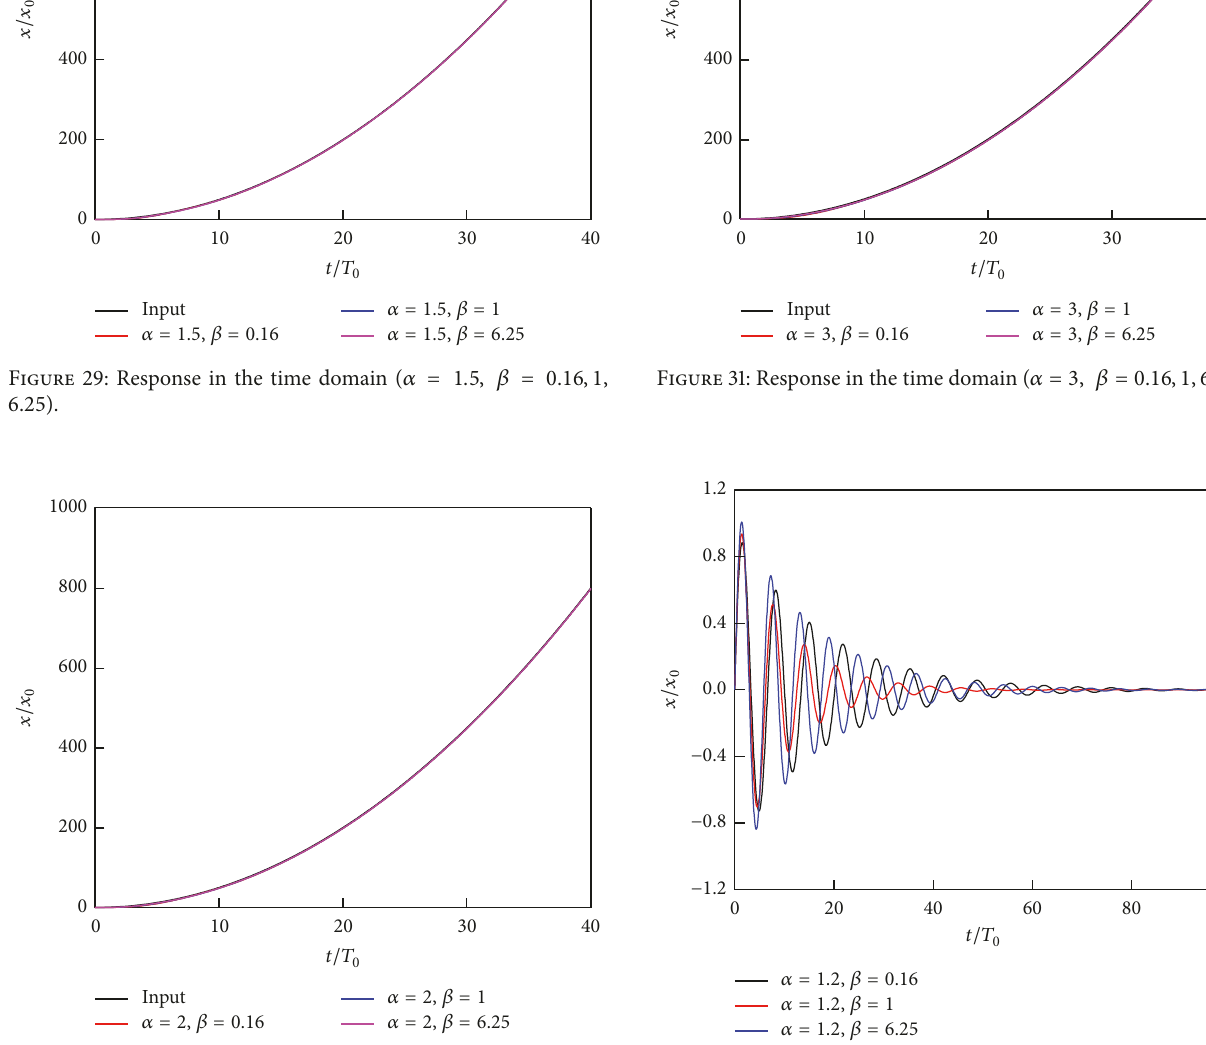
Figure 30: Response in the time domain ( 𝛼 = 2, 𝛽 = 0.16, 1,6.25 ).